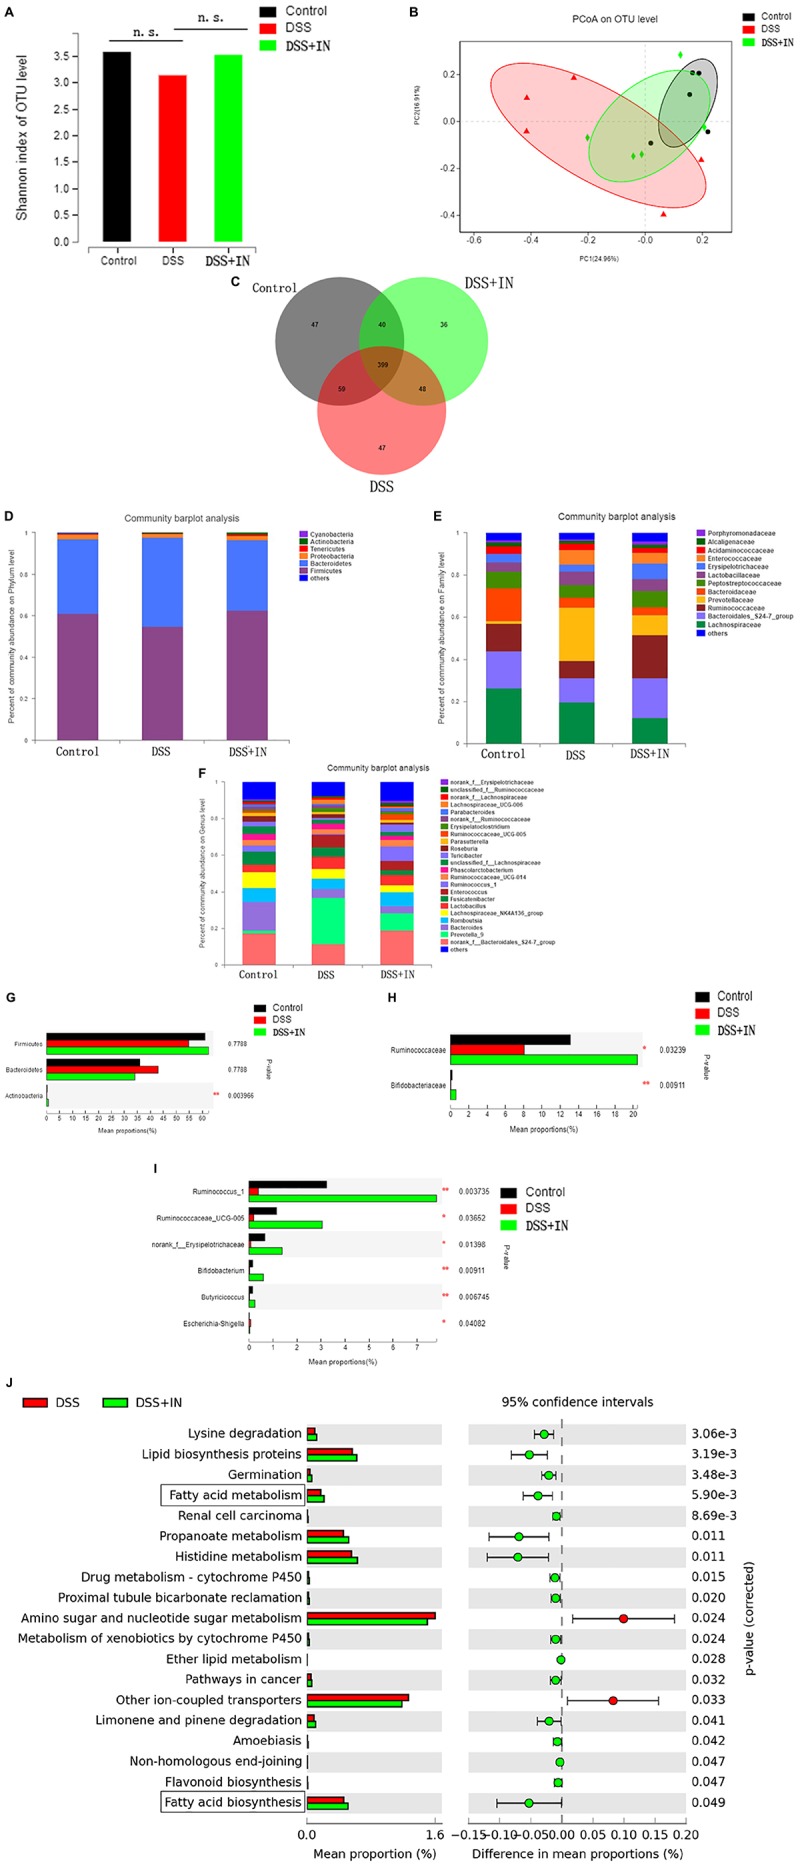
Indigo naturalis supplementation significantly alleviates DSS-induced gut dysbiosis in rats. (A) Shannon indexes; (B) PCoA plots; (C) Venn diagram of OTUs; (D–I) relative abundances of bacterial groups at the phylum (D), family (E), and genus (F) levels and statistical significance among the three groups at the phylum (G), family (H), and genus (I) levels, tested by means of Kruskal–Wallis H tests; (J) microbial community functions predicted by PICRUSt using STAMP (version 2.1.3). n.s. means no statistical significance; **P < 0.01, *P < 0.05 versus the DSS group.